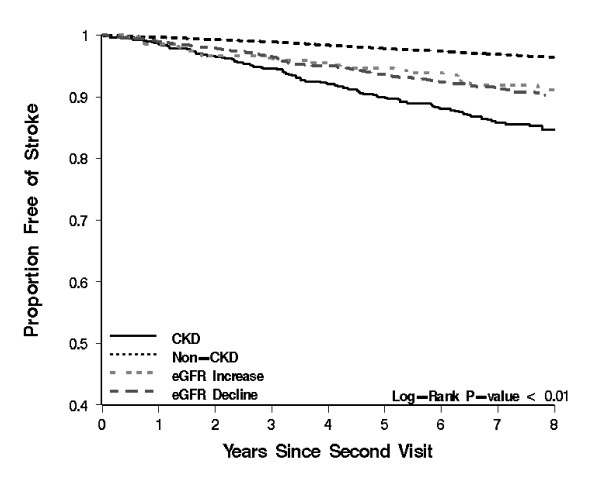
Kaplan-Meier curves presenting the relationship between kidney function groups and Stroke outcomes.